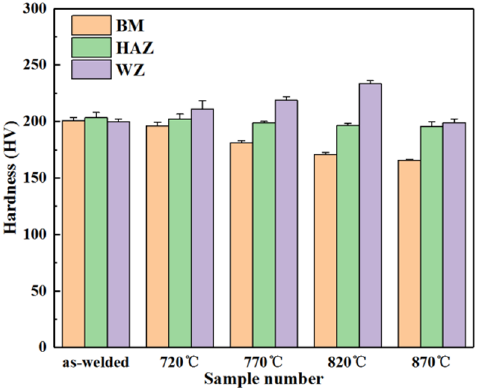
Figure 17. Mean and error of hardness at different heat treatment temperatures.